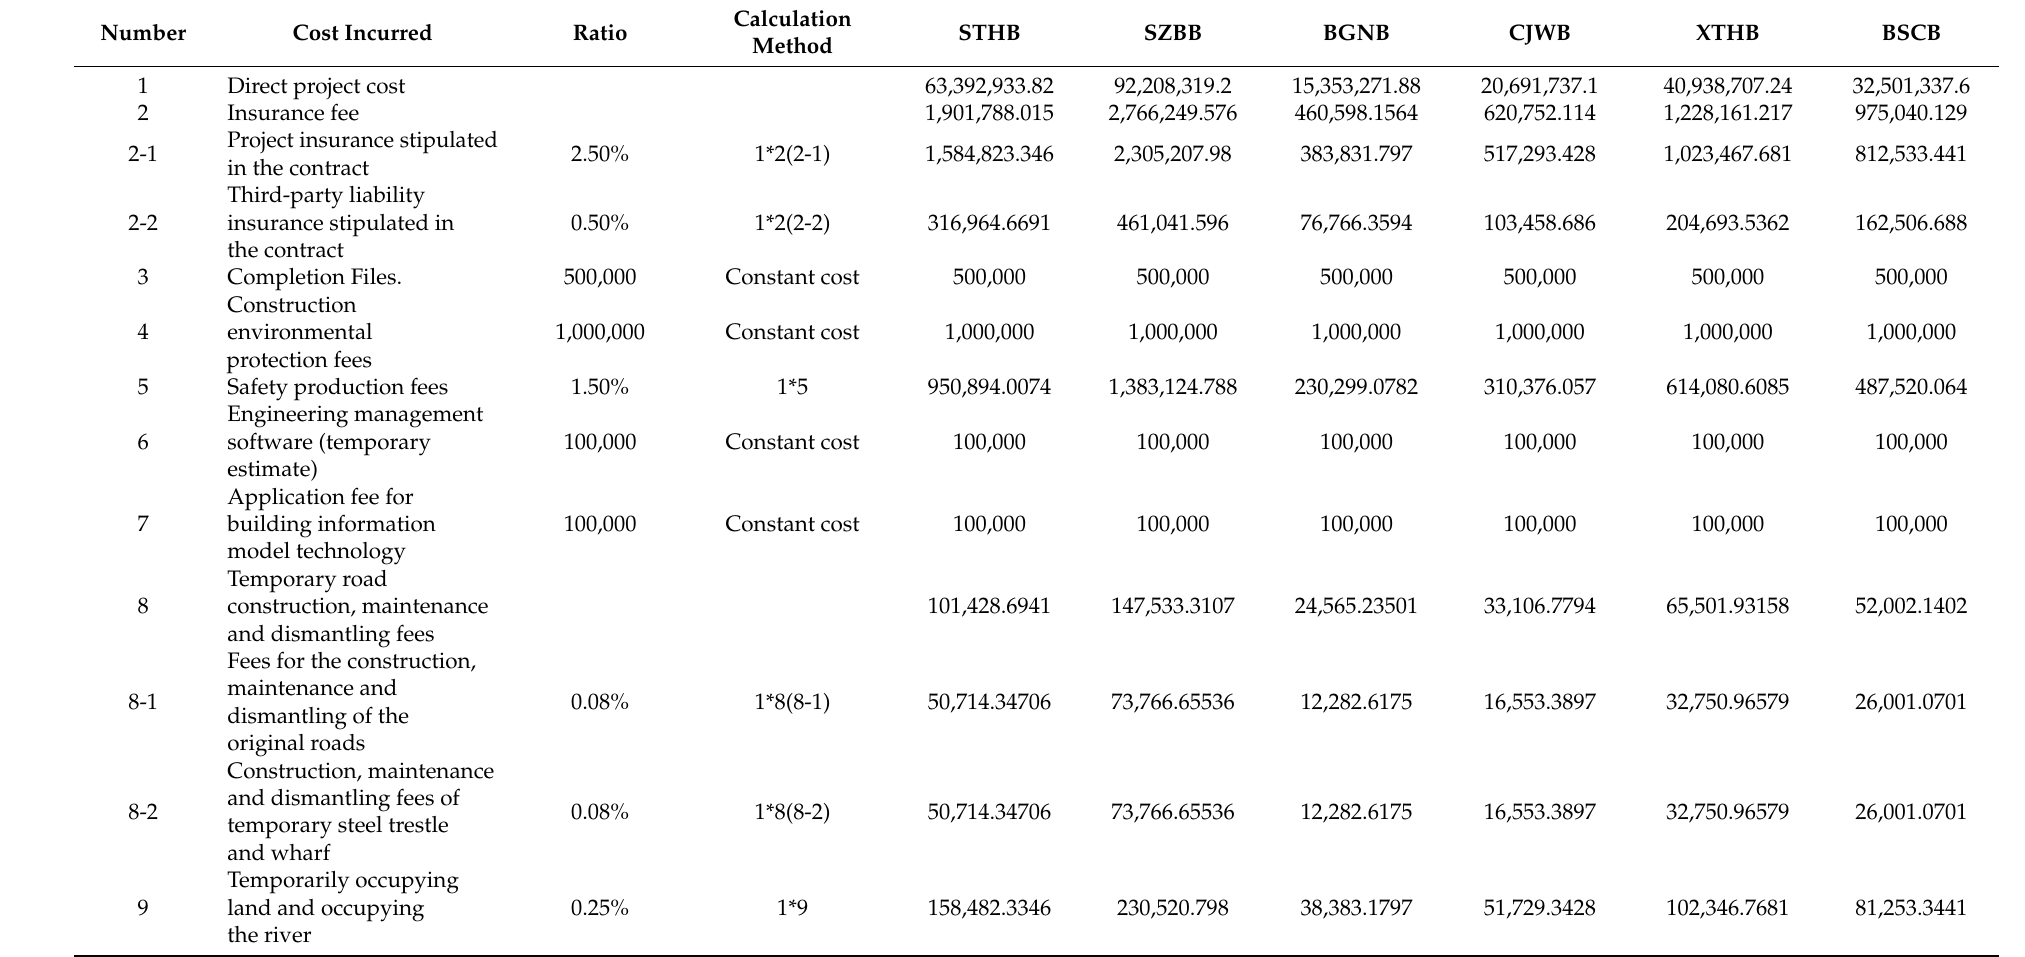
Table 4. Statistical table of construction cost of six cable-stayed bridge projects ([91]). Unit: